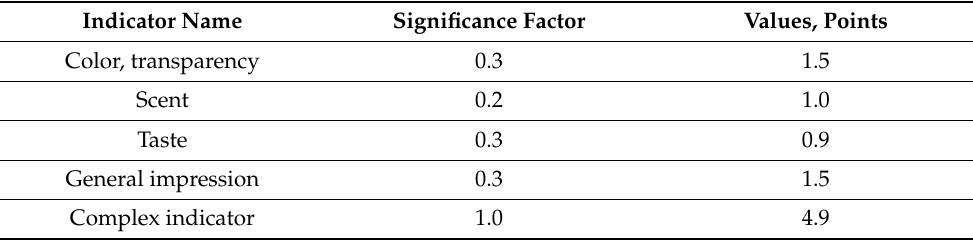
Table 2. Organoleptic evaluation of extracts based on Schisandra Chinensis (Turcz. Baill).